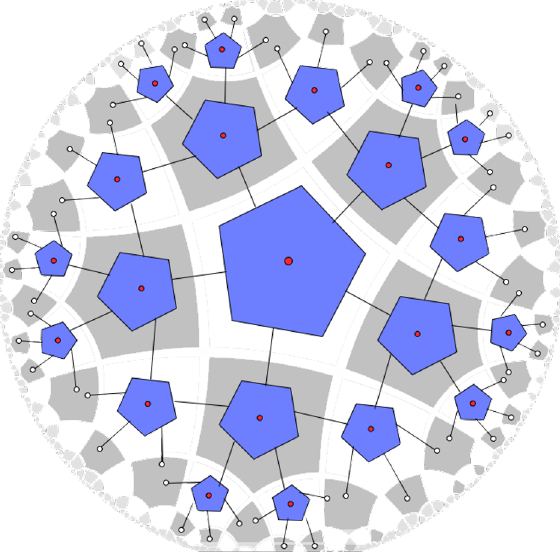
Figure 1 . The holographic pentagon code from [4]. Each blue pentagon represents a 6 leg perfect tensor (see definition 2.2) with legs partitioned to represent 5 physical output legs and 1 logical input leg (shown by the red